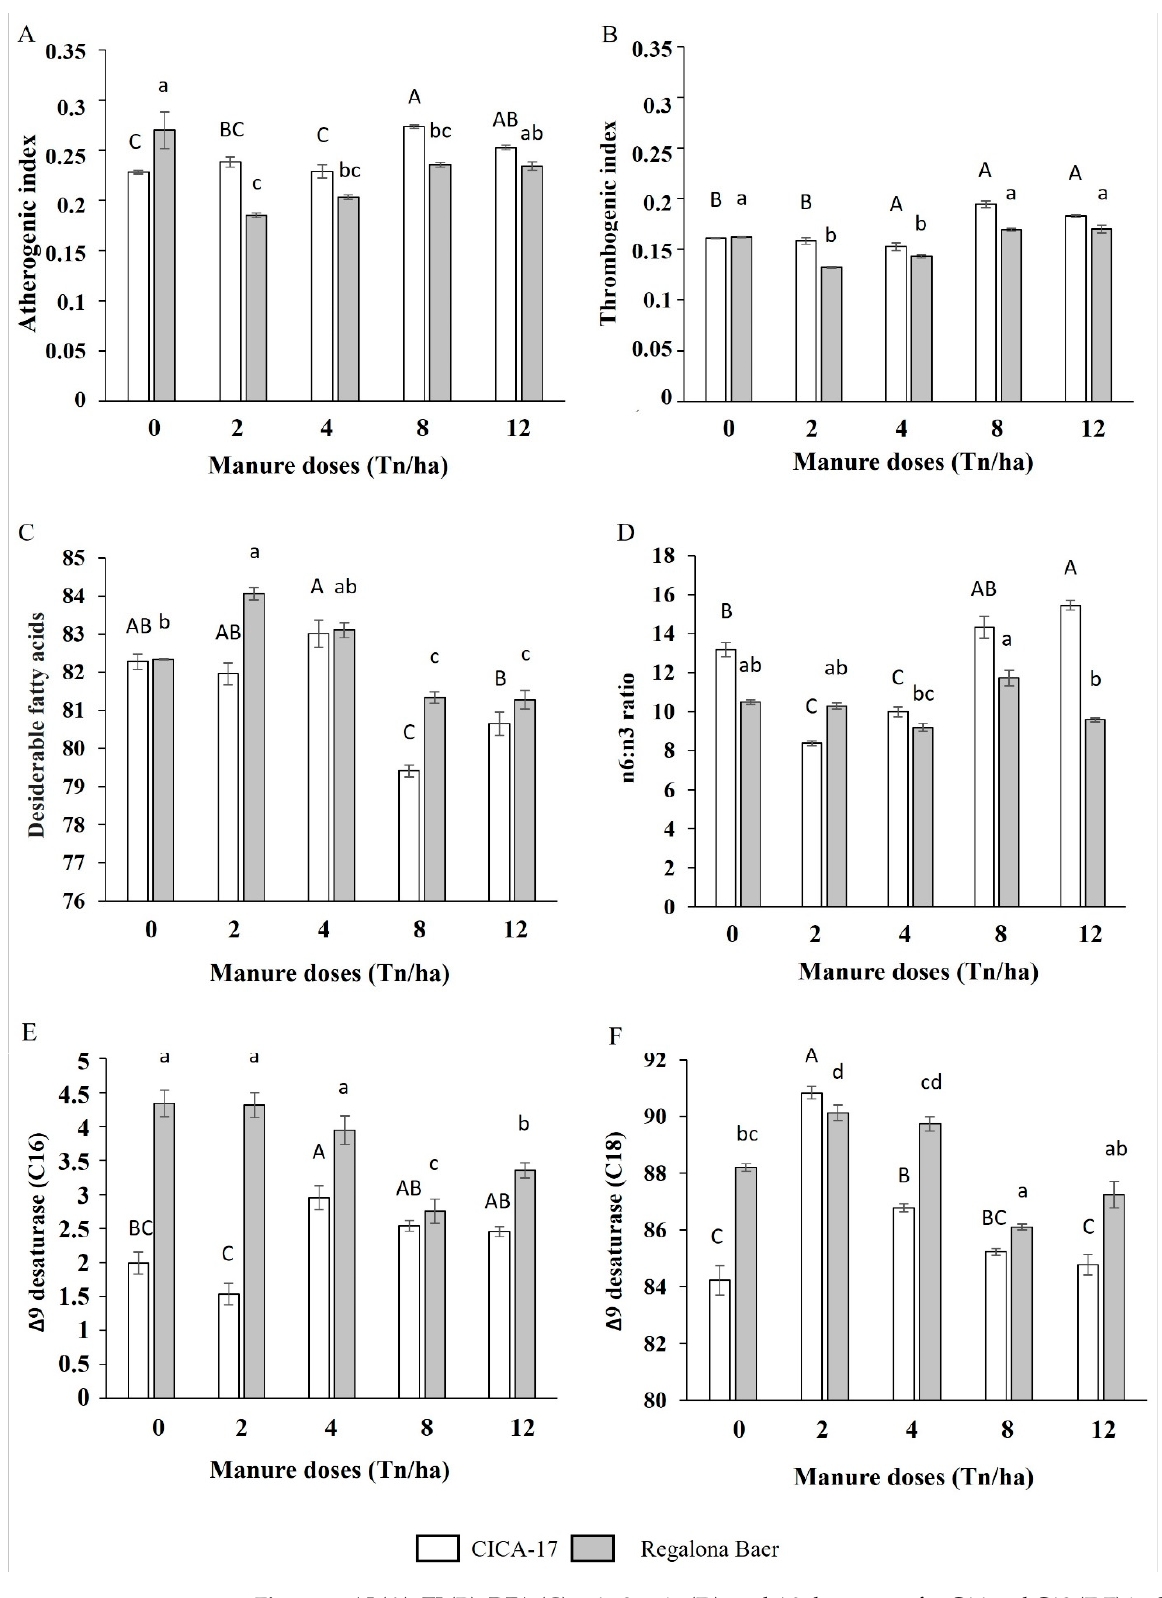
Figure 2. AI ( A ), TI ( B ), DFA ( C ), n6:n3 ratio ( D ), and ∆ 9 desaturase for C16 and C18 ( E , F ) in CICA-17 and Regalona Baer varieties after manure addition to soil. Values correspond to the mean ± SE ( n =